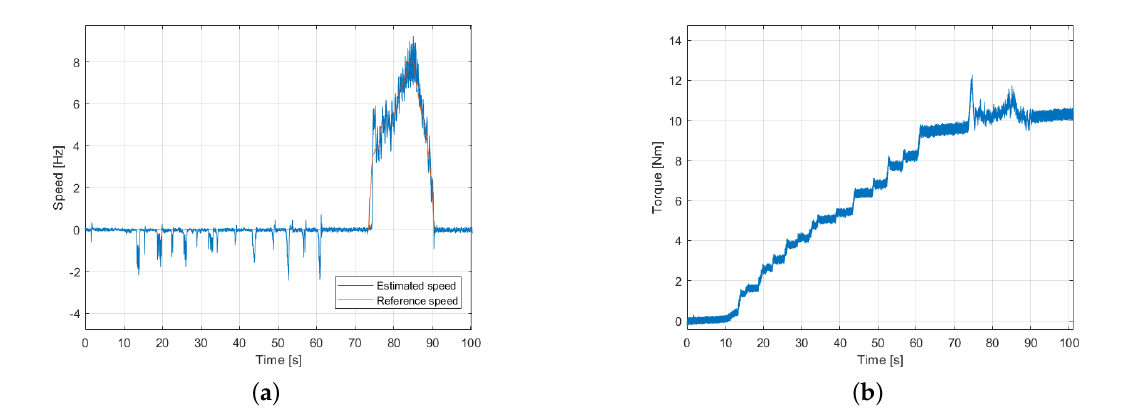
Figure 15. Loaded behaviour at standstill and start-up. ( a ) Speed tracking. ( b ) Torque produced.